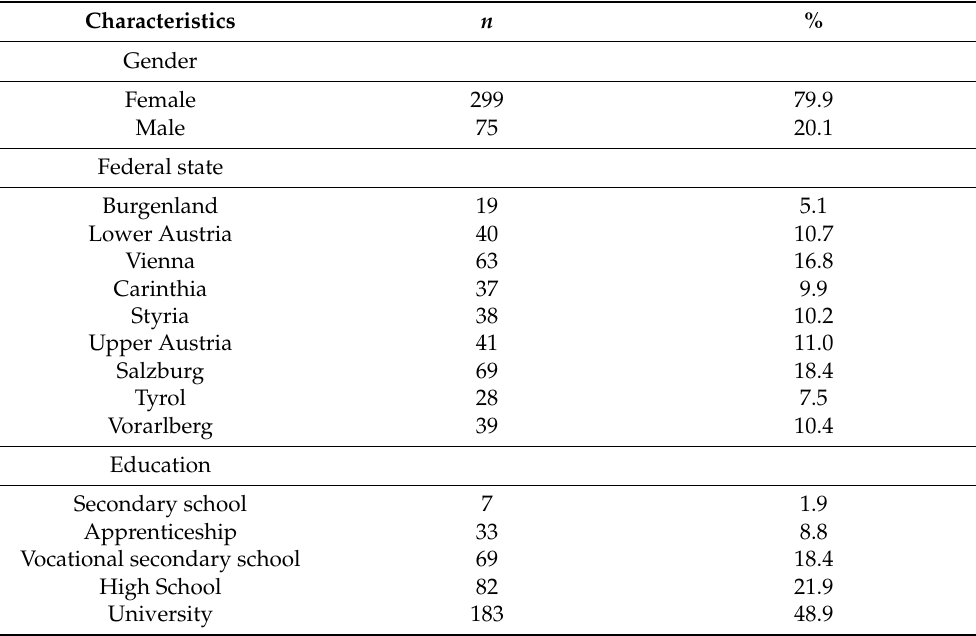
Table 1. Sociodemographic characteristics of the